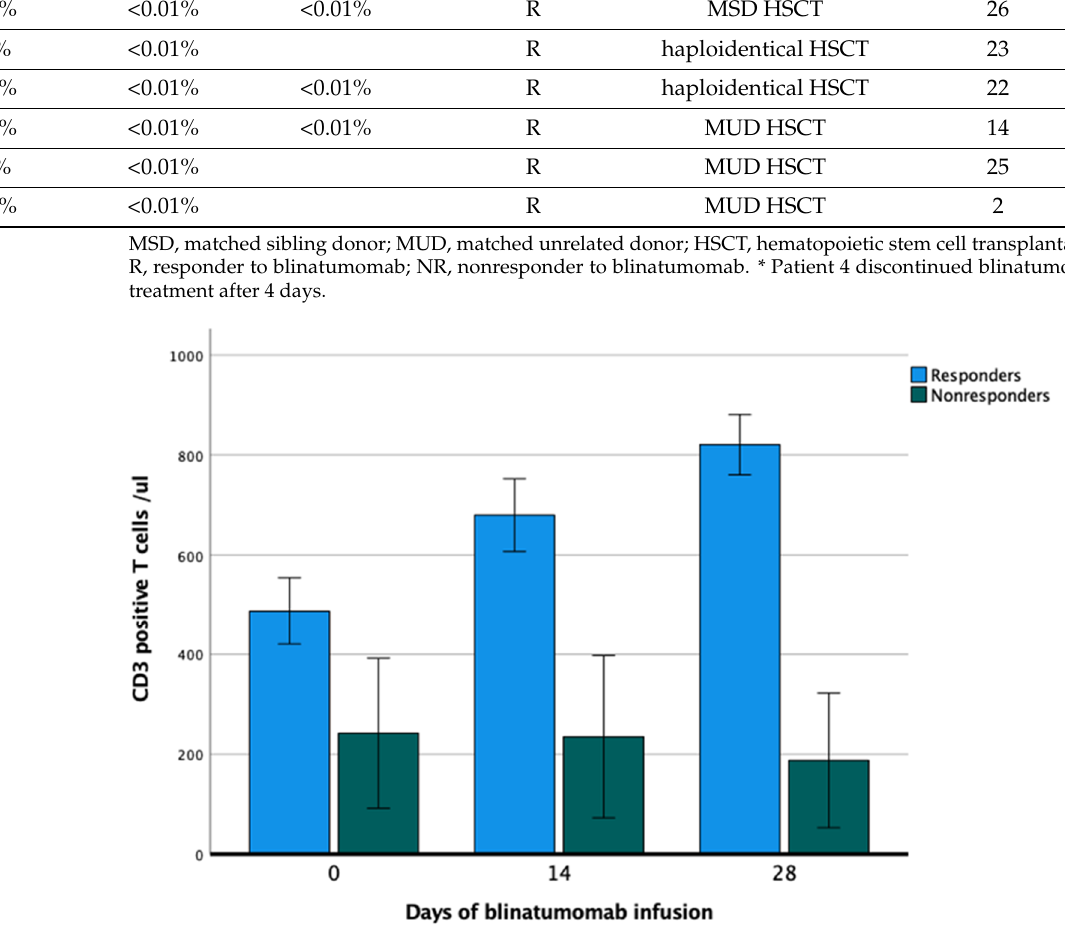
Figure 2. T-cell kinetics during first blinatumomab cycle (days 0, 14, and